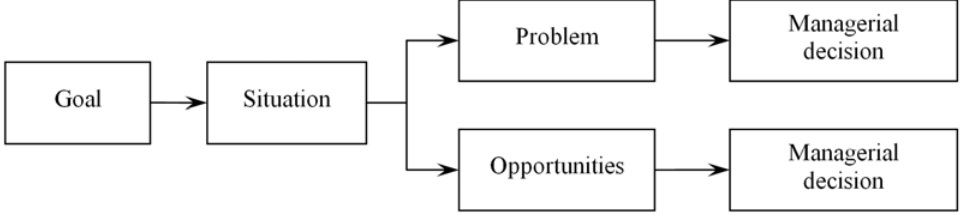
Fig. 4. Management cycle that takes into account the opportunities of the organization’s